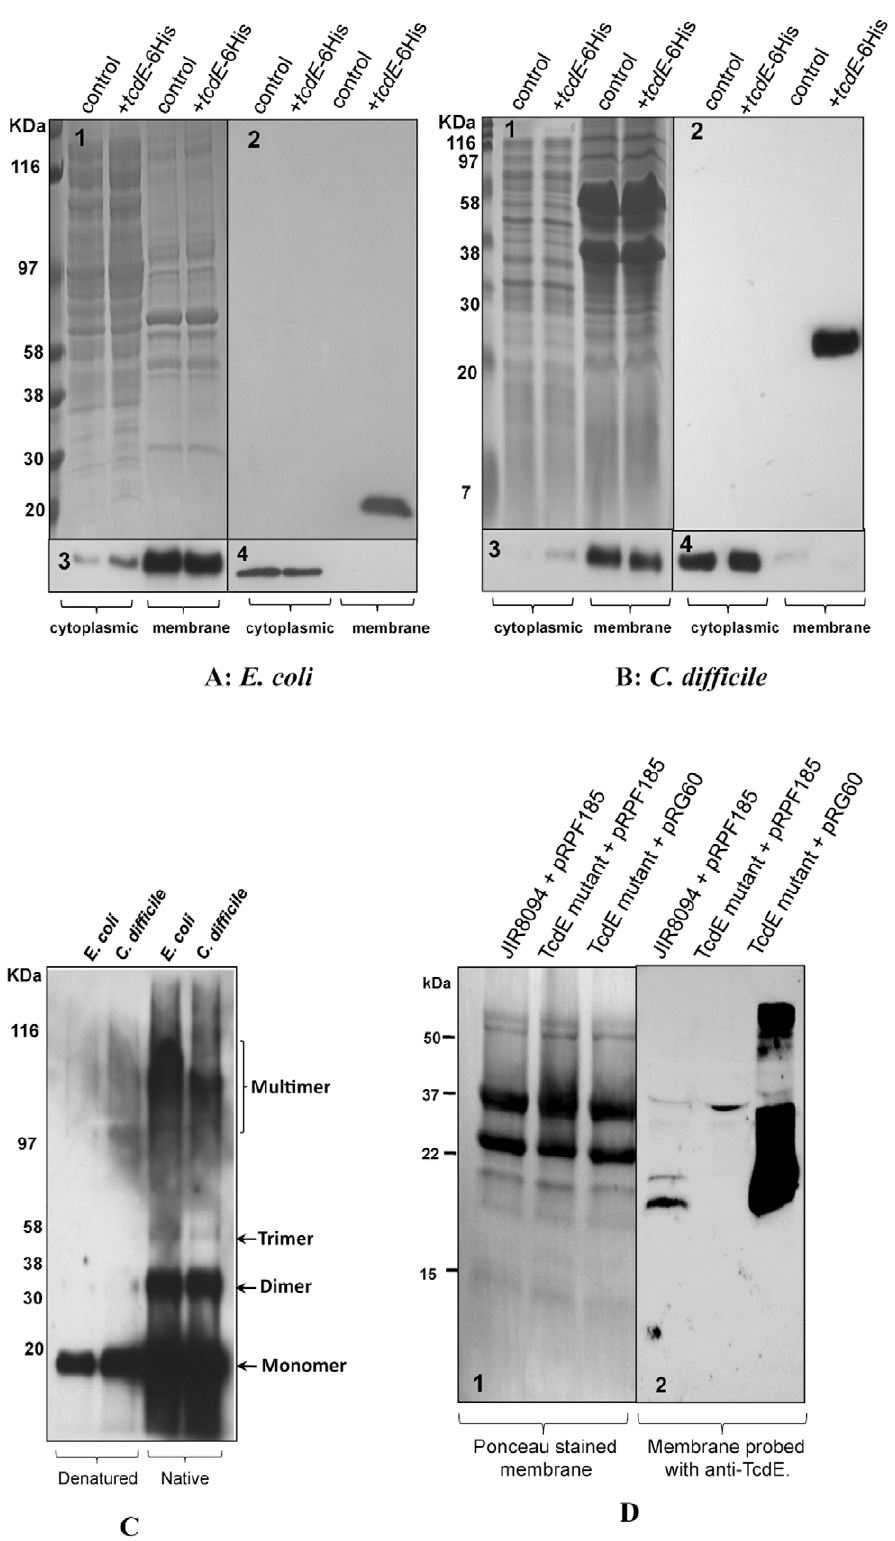
Figure 9. Localization of TcdE in E.coli and C.difficile . A. Cytoplasmic and membrane proteins analysis of E. coli lysogens of l Cmr D (SR) carrying pBR322 (control) or pCD463 ( + tcdE -6xHis). B. Cytoplasmic and membrane proteins analysis of C. difficile strain carrying either pMTL84151 (control) or pRG46 ( + tcdE -6xHis). (1) SDS-PAGE coomassie stained gel. Western blots probed with 6XHis Tag antibody (2), ATPase Beta subunit antibody (3), and Ribosomal subunits LI/L2 monoclonal antibody (4). C. Membrane protein samples from bacterial cells expressing TcdE-6His resuspended in denature or native sample buffers and analyzed by Western blot using His-Tag antibody. D. Membrane proteins of JIR8094, TcdE mutant and complemented